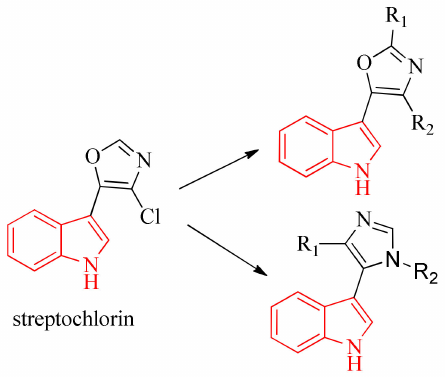
Figure 2. Oxazole and Imidazole analogues of streptochlorin.